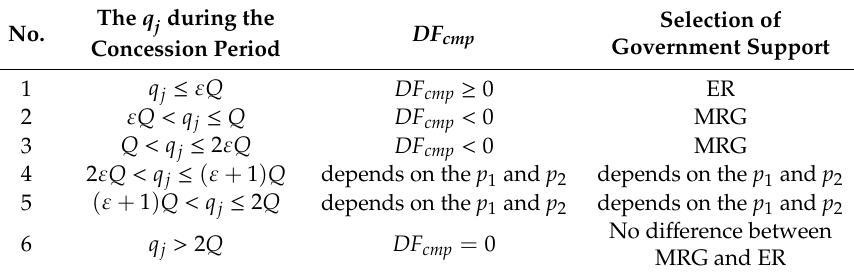
Table 1. Decision factor in di ff erent scenarios of service demand.